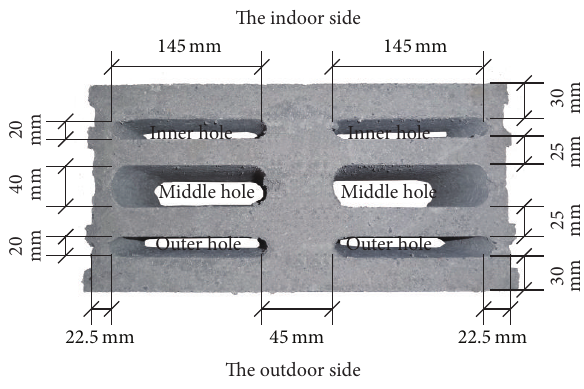
Figure 1: The actual object and size of block.